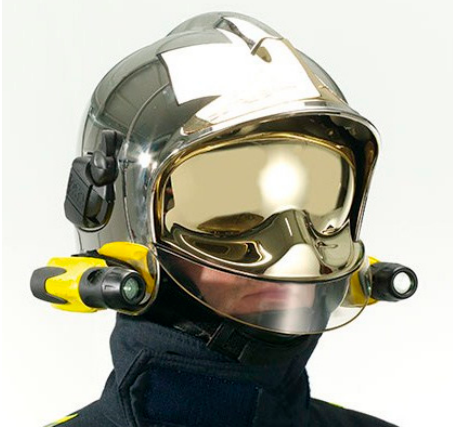
Figure 2. A proposed Firefighter helmet with integrated smart see-through augmented reality